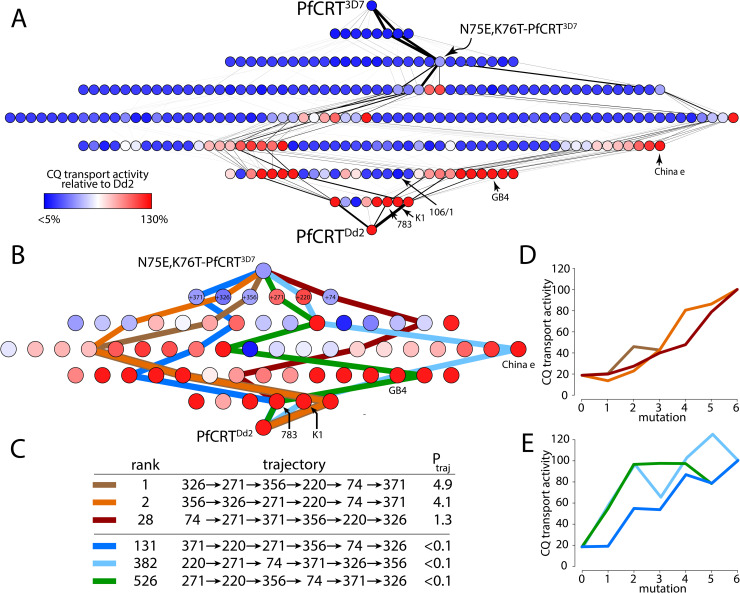
Selection for increased CQ transport activity strongly constrains trajectories through the map.A) Calculated trajectories through the complete genotype-phenotype map. The edges indicate the probability of a mutation over all possible trajectories from low (thin lines) to high (thick lines). The nodes indicate CQ transport activity as defined in Fig 1. B) Six example trajectories through the map between N75E,K76T-PfCRT3D7 and PfCRTDd2. C) The rank-order and mutational routes of the six trajectories shown in panel B. The Ptraj value indicates the relative probability of the trajectory. Panels D,E show CQ transport activity as a function of mutation step for the trajectories presented in panels B,C.